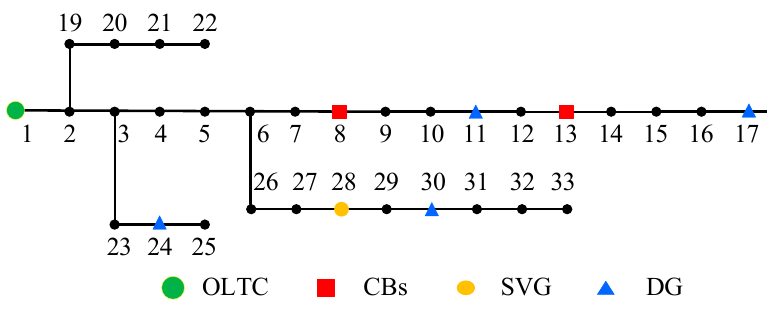
Figure 2. Topology of 33-bus distribution network. Table 1. Parameters of DG.